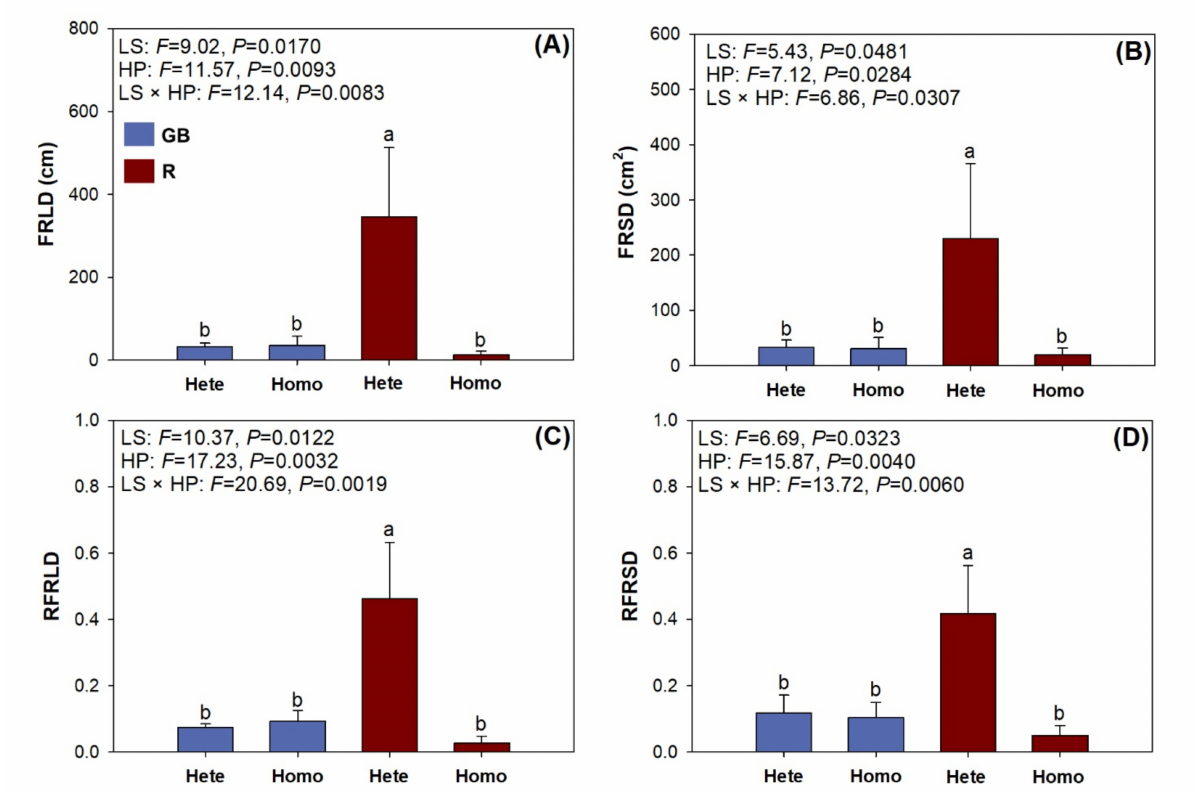
Figure 7. Fine root differences between pot-halves for length (FRLD) and surface area (FRSD), and their relative values (RFRLD and RFRSD, respectively) in Pinus pumila seedlings subjected to green-and-blue light (GB) and red-light enriched spectra (R) in heterogeneous (Hete) and homogeneous (Homo) nutrient patterns. Error bars indicate standard deviations. Different letters above the bars indicate significant difference according to Duncan test at the 0.05 level. ( A ) FRLD, ( B ) RFSD, ( C ) RFRLD, and ( D ) RFRSD in seedlings subjected to combined nutrient pattern and light